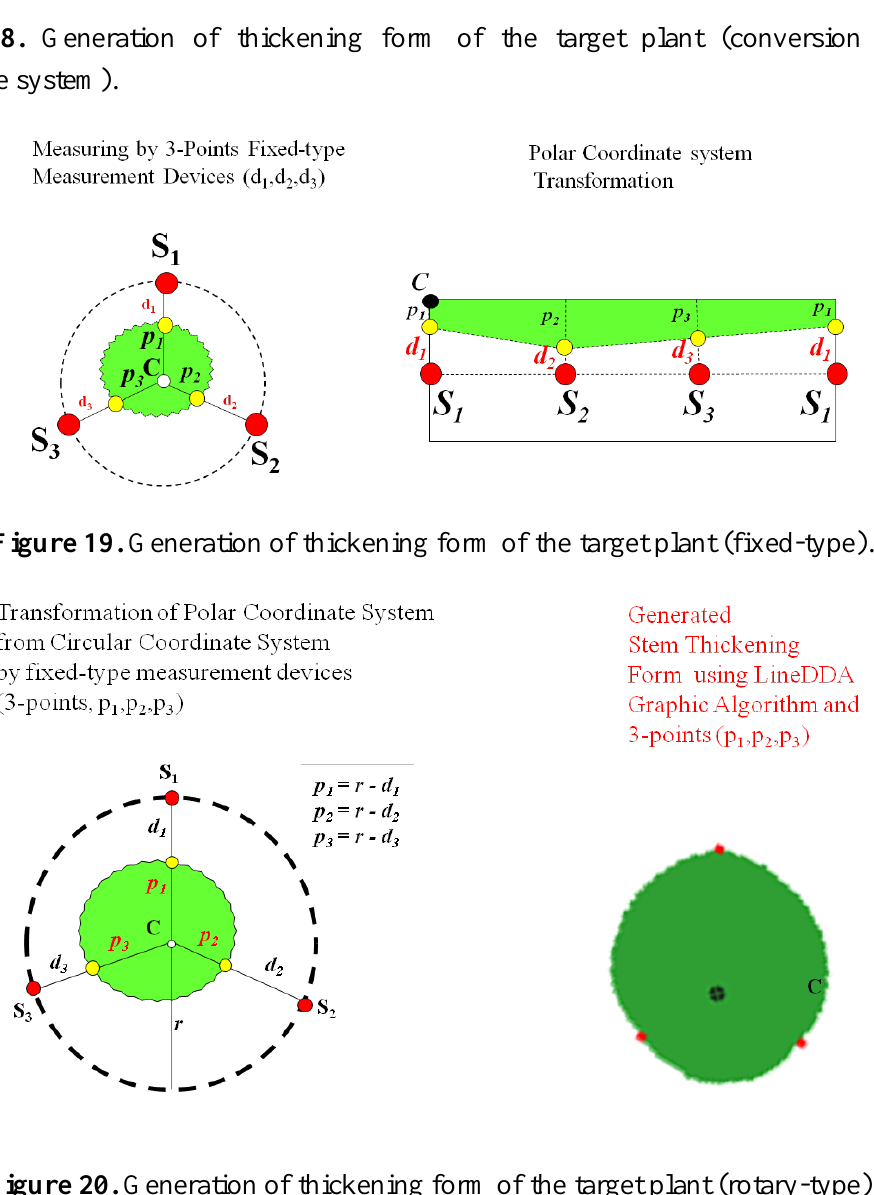
Figure 18. Generation of thickening form of the target plant (conversion to polar coordinate system).